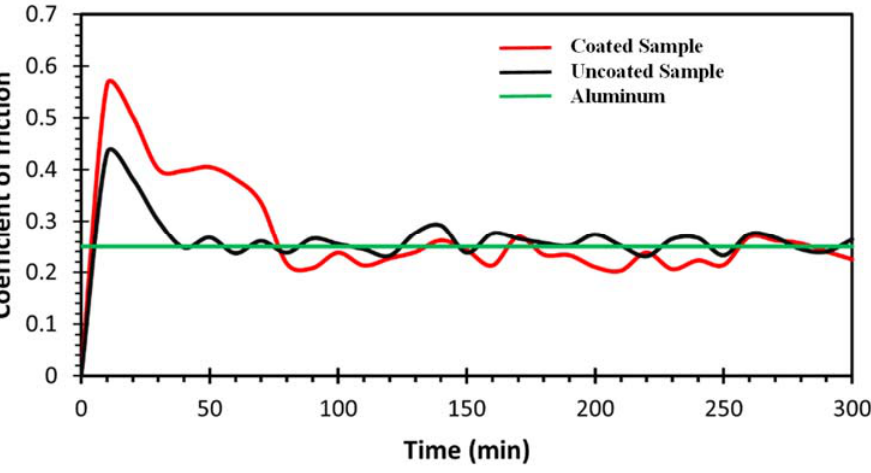
Figure 5. Coefficient of friction (COF) of aluminum, uncoated, and coated nanocomposite samples.